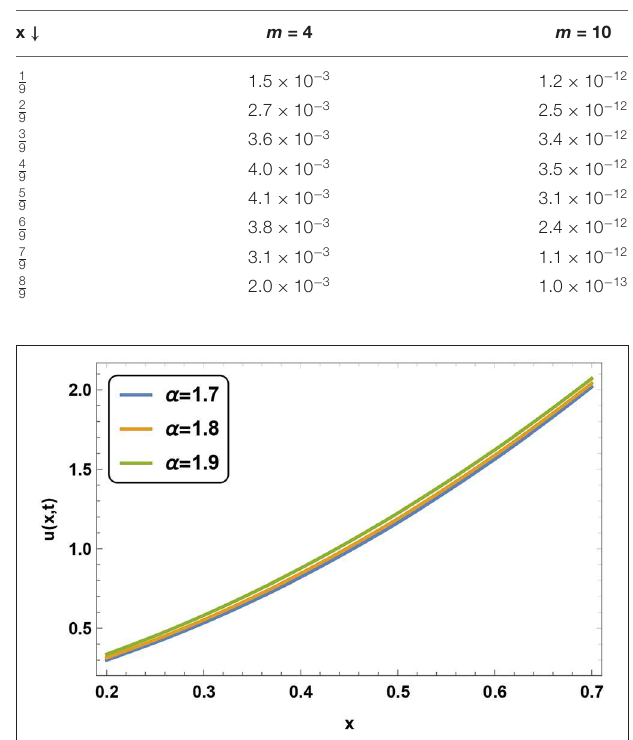
TABLE 3 | Deviation of absolute error for different m at time t = 0.1.